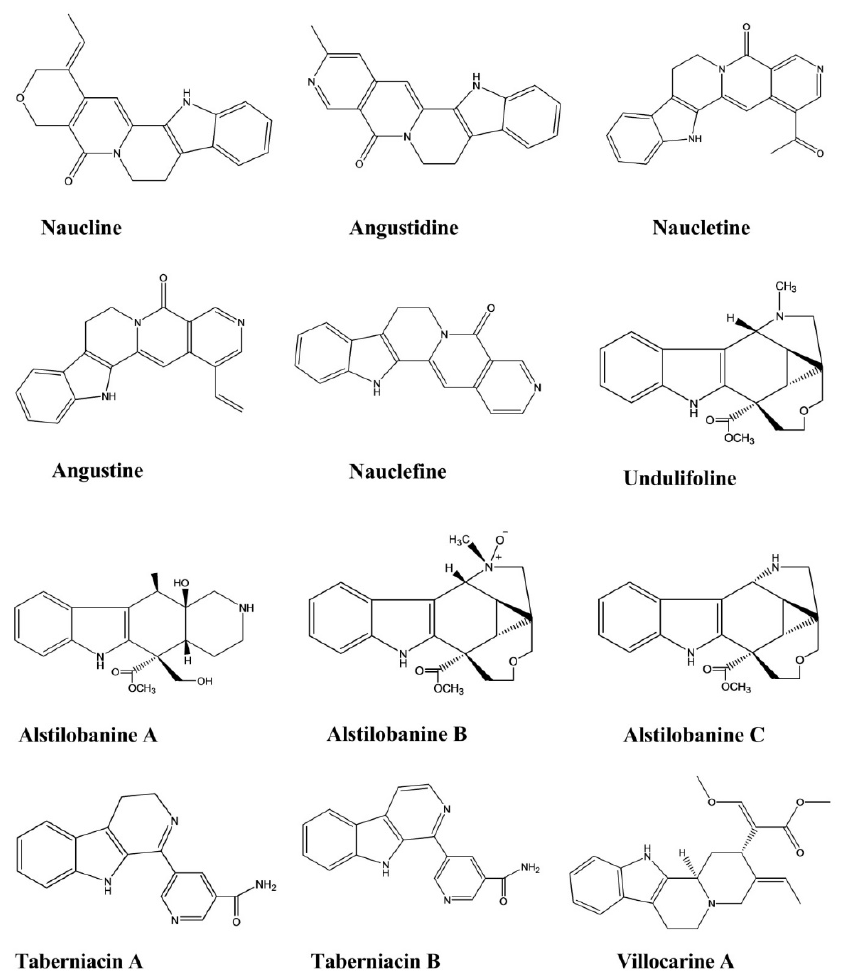
Figure 11. Hypotensive activity of indole alkaloids.